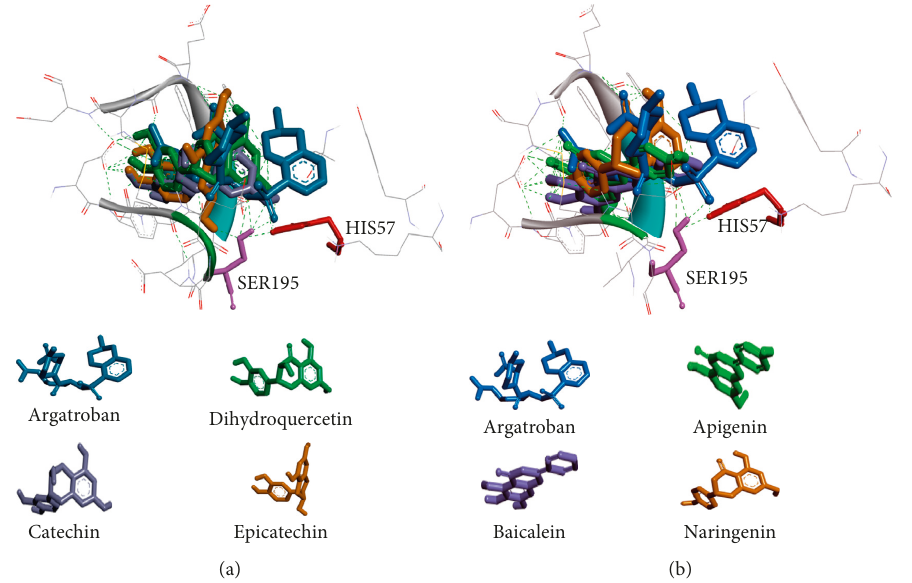
Figure 5: Comparison of 3D structures of six flavonoids docked with the thrombin catalytic site. (a) The 3D structures of argatroban, dihydroquercetin, catechin, and epicatechin; (b) the 3D structures of argatroban, apigenin, baicalein, and